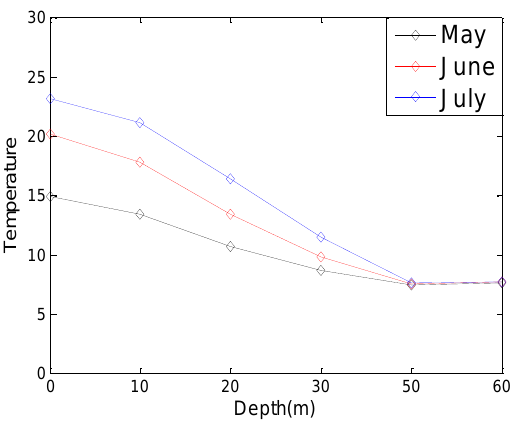
Figure 4. Average salinity in a year.